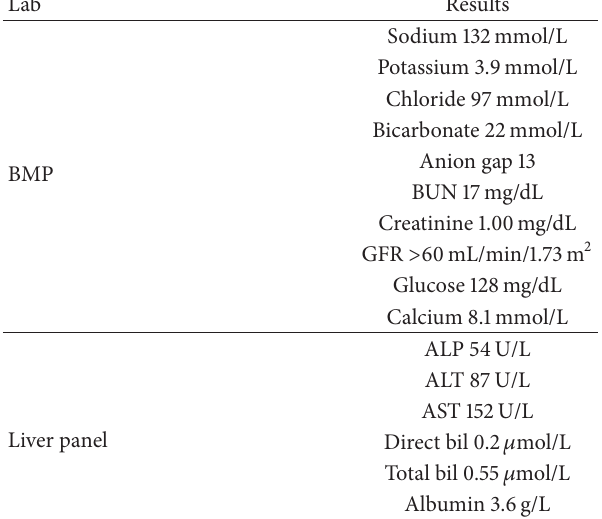
Table 2: Panel of infectious lab tests and results. Mono may be falsely positive in autoimmune disease, confirmatory EBV test negative. Galactomannan positive.